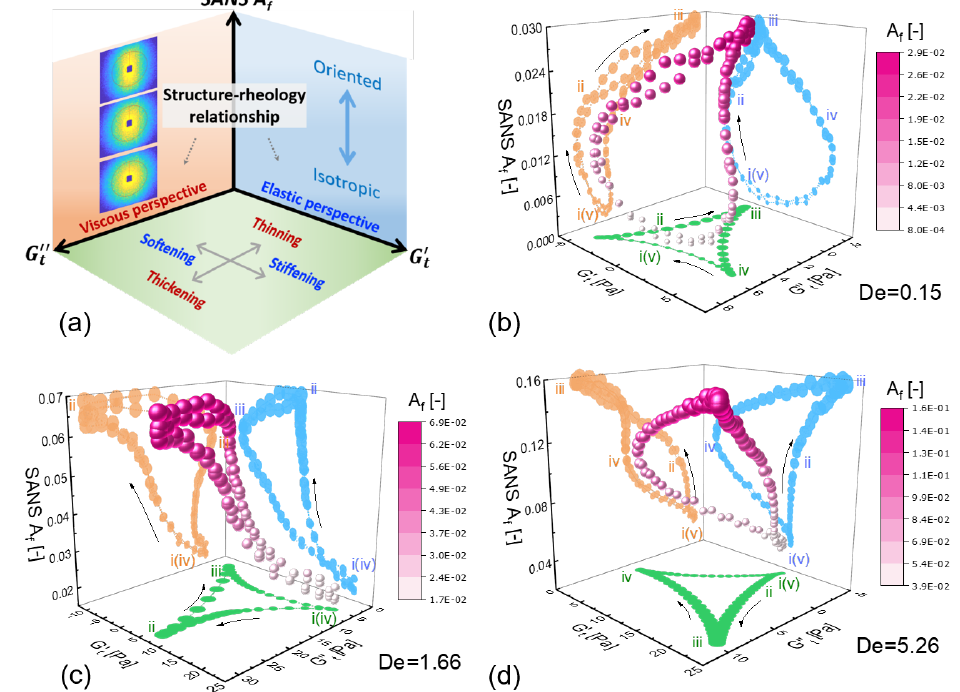
Figure 5. Microstructural evolution is coupled with rheology via rheo-SANS and sequence of physical processes (SPP) techniques under dynamic shearing. ( a ) 3D space [ G (cid:48) t , G (cid:48)(cid:48) t , A f ] constituted by the time-dependent SPP moduli and SANS alignment factor. The structure–rheology correlation under LAOS laid out by the 3D space of [ G (cid:48) t , G (cid:48)(cid:48) t , A f ] at the investigated normalized frequencies of De = 0.15 ( b ), De = 1.66 ( c ) and De = 5.26 ( d ), where the degree of alignment is indicated with a color